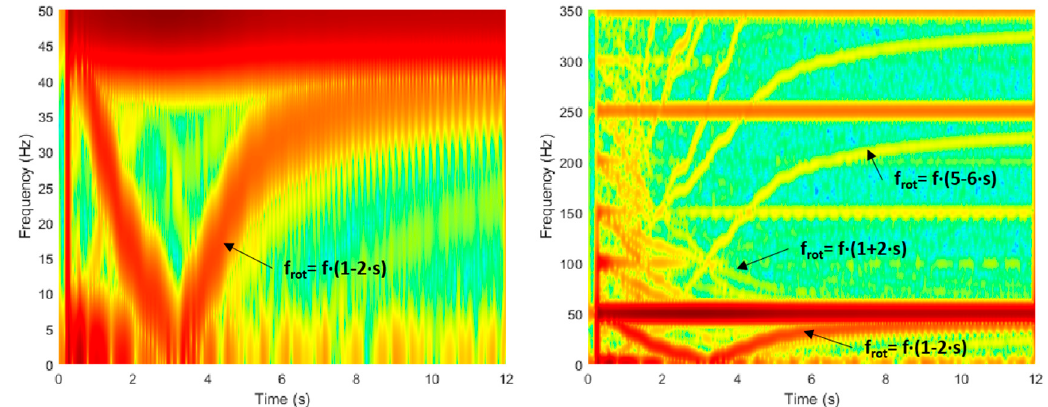
Figure 10. Time-frequency maps of the starting current for a H.V. wound rotor induction motor of a cement plant.